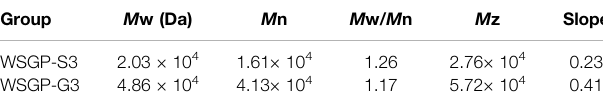
Frontiers in Pharmacology |